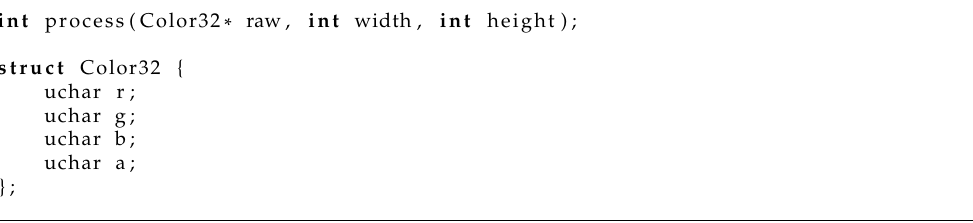
Algorithm 1 C++ external function and pixel colour